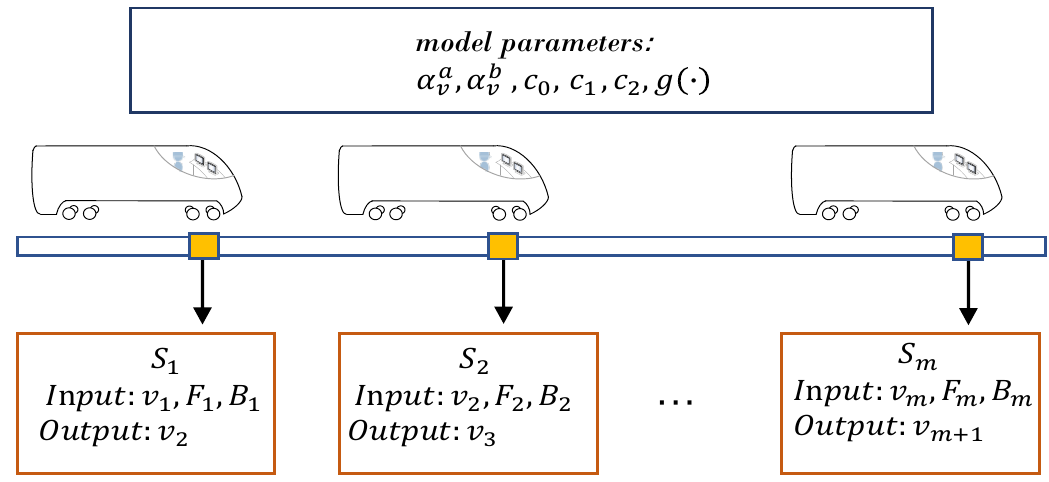
Figure 1. Parametric based train dynamic